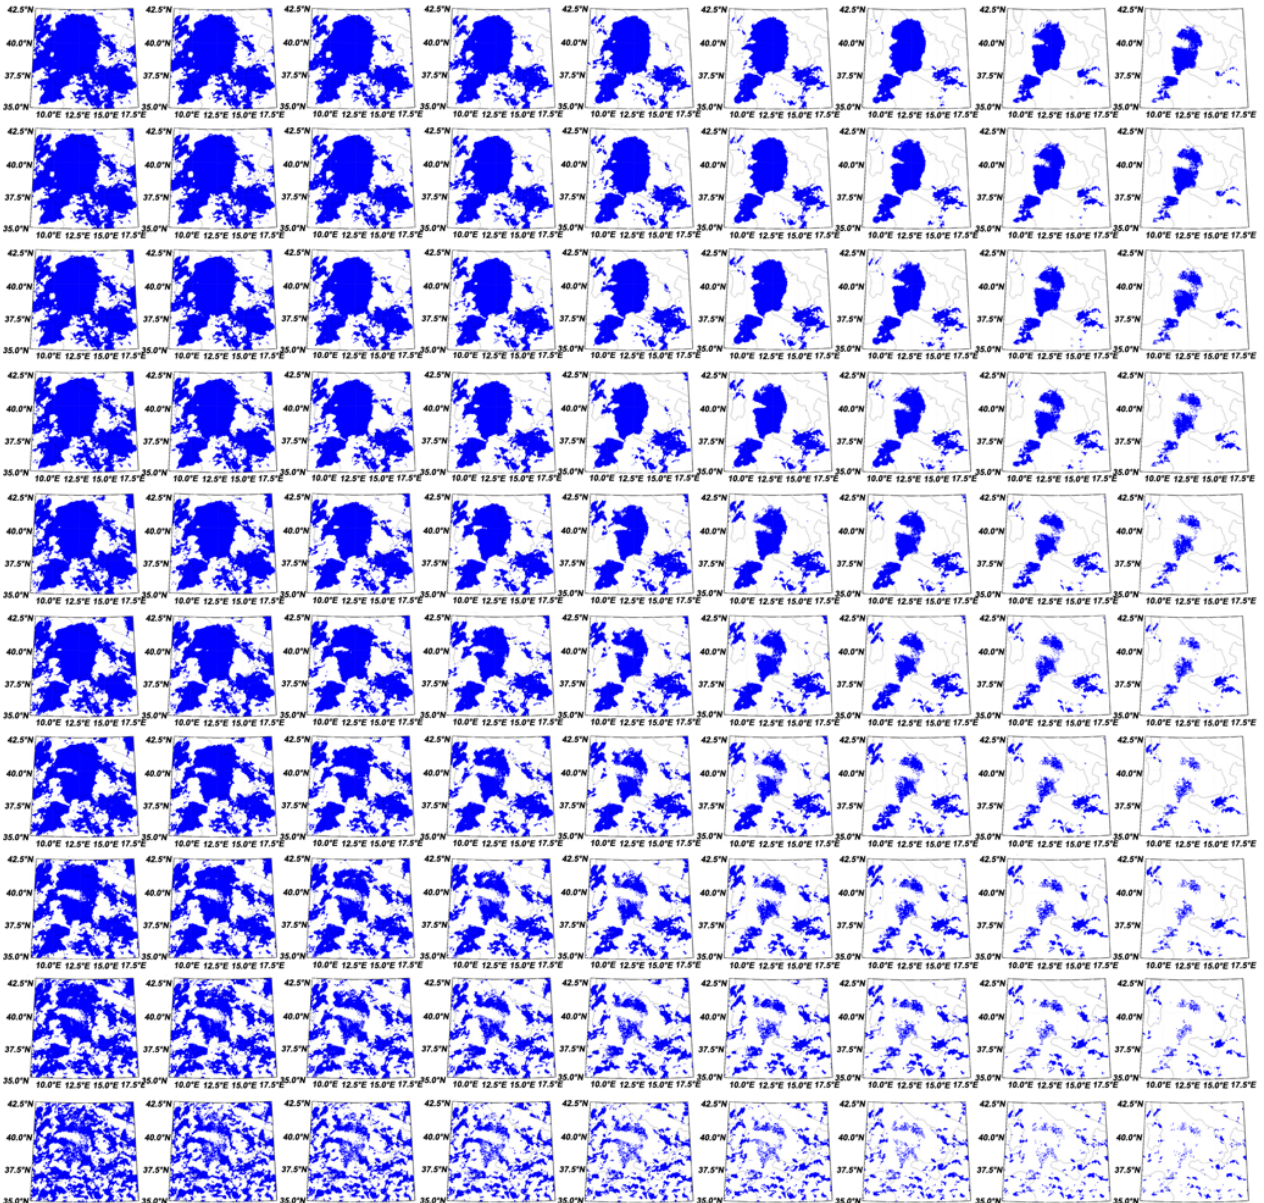
Fig. 3. Flag matrices computed on 1 October 2009 at 12:57UTC, used for pattern recognition in Morphing module. From top to bottom N box size decreases from 250px to 25px by step of 25px, while from left to right P percentile decreases from 50% to 10% by step of